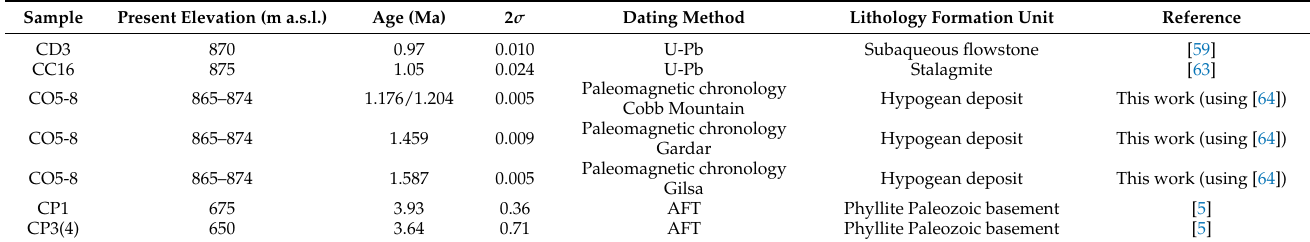
Table 2. Ages used to estimate the uplift